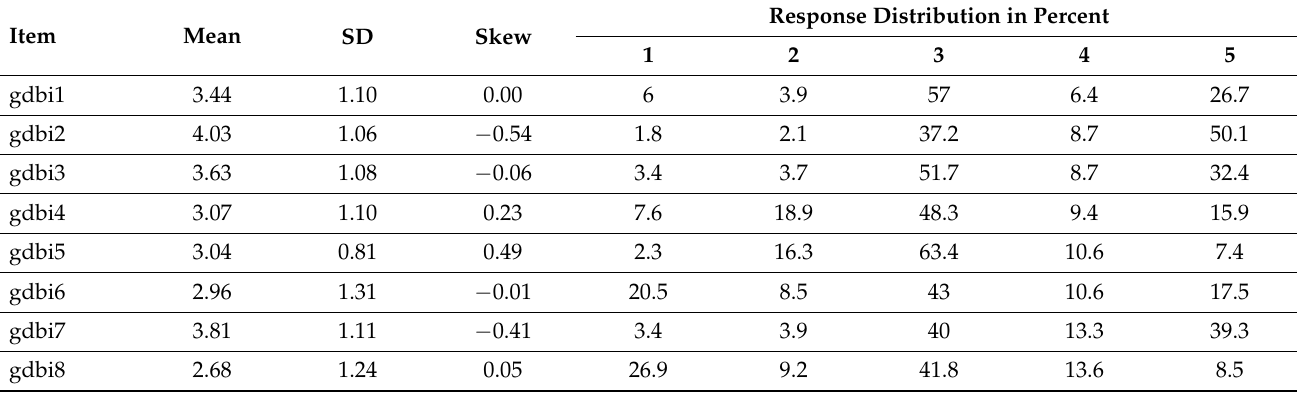
Table 2. Descriptive item statistics of the GDBI